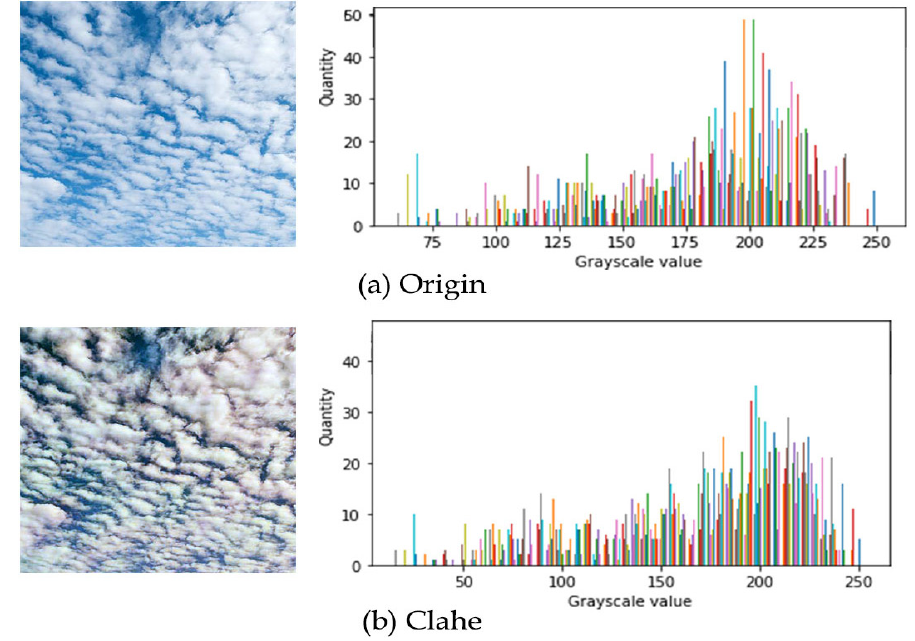
Figure 4. ( a ) The original image and its grayscale histogram. ( b ) The image is processed by Clahe and its grayscale histogram.